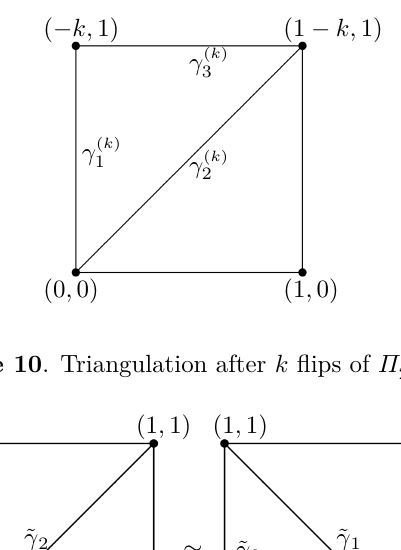
Figure 11 . Acting on the initial triangulation with ˆ T gives a triangulation that puts ˜ γ position to be unflipped.